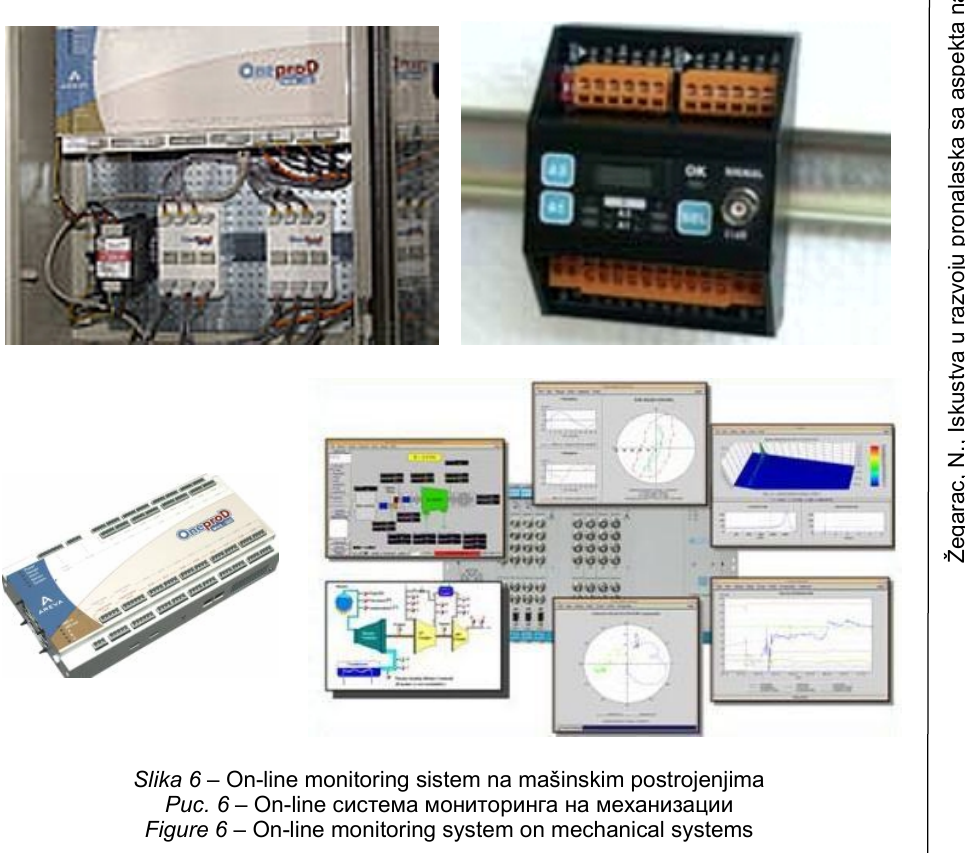
Figure 6 – On-line monitoring system on mechanical